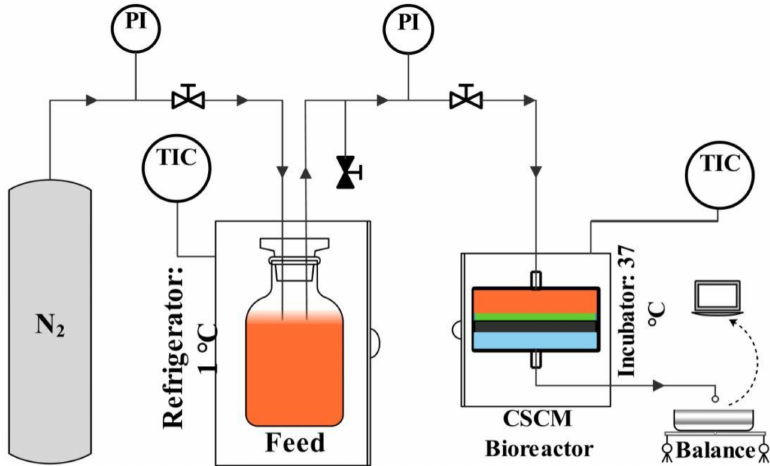
Figure 1. Ceramic supported carbon membrane bioreactor experimental